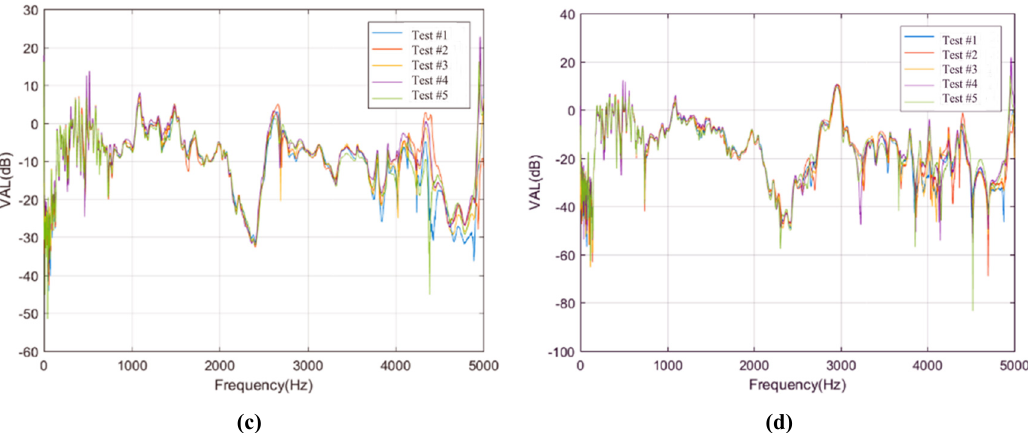
Figure 10. Acceleration level differences of the sensors on rails. ( a ) Acceleration level differences of sensor R1F3 in Condition #1; ( b ) Acceleration level differences of sensor R1F5 in Condition #1; ( c ) Acceleration level differences of sensor R1J3 in Condition #2; ( d ) Acceleration level differences of sensor R1J5 in Condition #2.